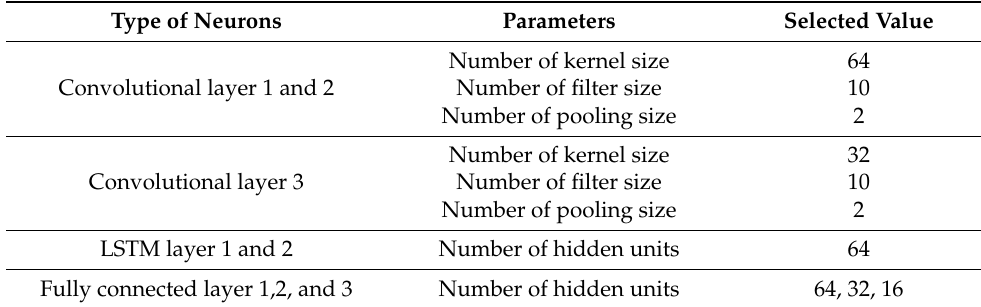
Table 1. List of selected parameters of the proposed approach.